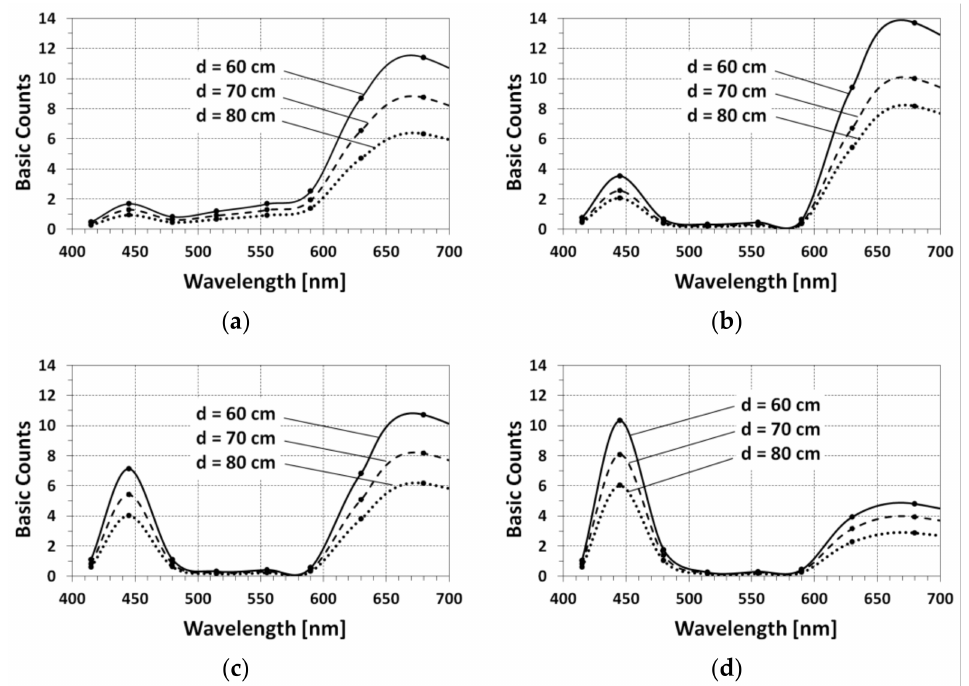
Figure 1. ( a ) Module 5HR:1DB:6WW, ( b ) module 9HR:3DB, ( c ) module 6HR:6DB and ( d ) module 3HR:9DB: light spectrums obtained using the low cost AS7341 spectral sensor. Each curve is obtained by the interpolation of the dimensionless output values of the 8 optical channels of the sensor with filters centered at wavelengths of 415, 445, 480, 515, 555, 590, 630, and 680 nm, in order (marker dots) [37].